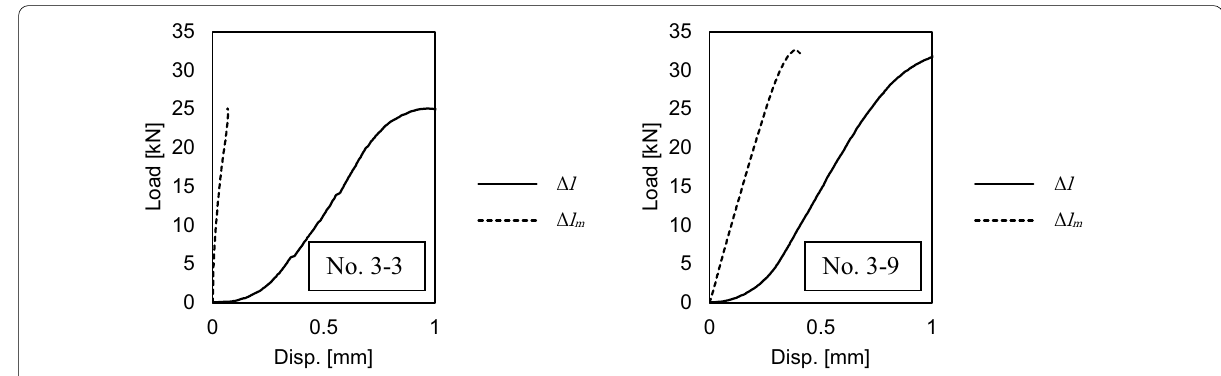
Fig. 10 Load ( P )–displacement (Δ l or Δ l m ) curve of no.3-3 and no.3-9